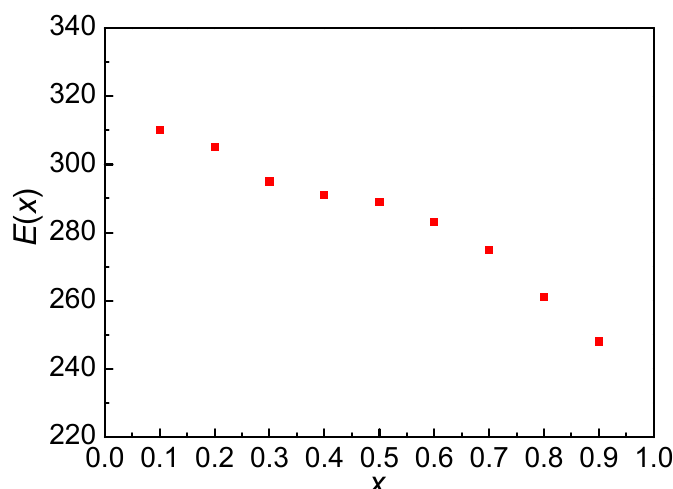
Figure 7. Relationship between local activation energy E ( x ) and the crystallization volume fraction x .